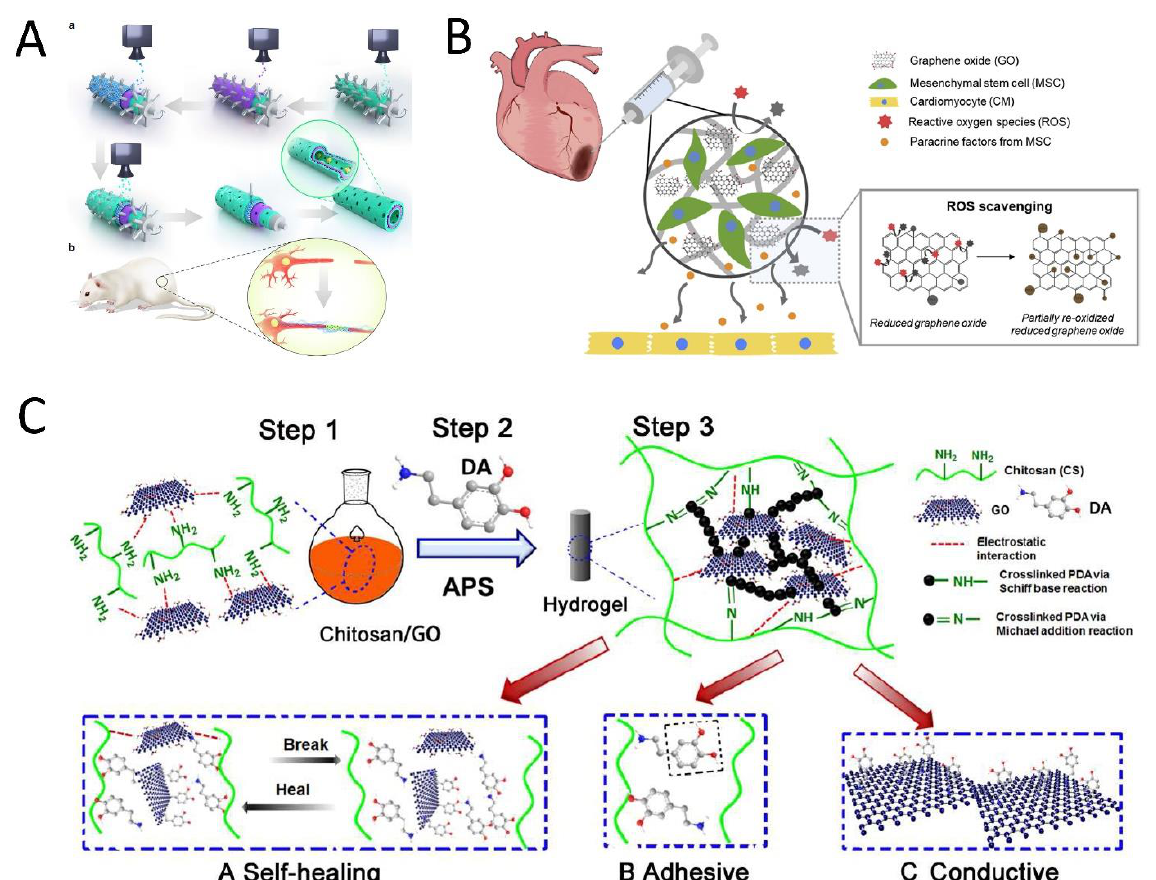
Figure 3. Schematic illustration of ( A ) the LBLC graphene nerve conduit. (a) The green layers are PDA/RGD adhesive macromolecules. The purple layer is single or multilayered graphene and the PCL-blended layer. The blue layer is the graphene and PCL-blended layer once more. (b) The GO/PCL nerve conduit in a sciatic nerve defect model in SD rats. Reused with permission from [30]. Copyright © 2021, Springer Nature. ( B ) rGO/alginate microgel embedding MSCs for cardiac tissue repair post-MI. Due to the loaded rGO, it was expected that encapsulated MSCs were protected from the severe oxidative stress in the infarcted tissue and facilitated cardiac regeneration. Reused with permission from [27]. Copyright © 2021, Elsevier Ltd. ( C ) CS-DA-GO composite hydrogel fabrication in three steps, which causes the enhanced properties of the hydrogel. (A) Self-healing mechanism of the hydrogel. (B) Self-adhesiveness of the hydrogel. (C) Enhanced conductivity. Reused with permission from [29]. Copyright © 2021, Elsevier Ltd.